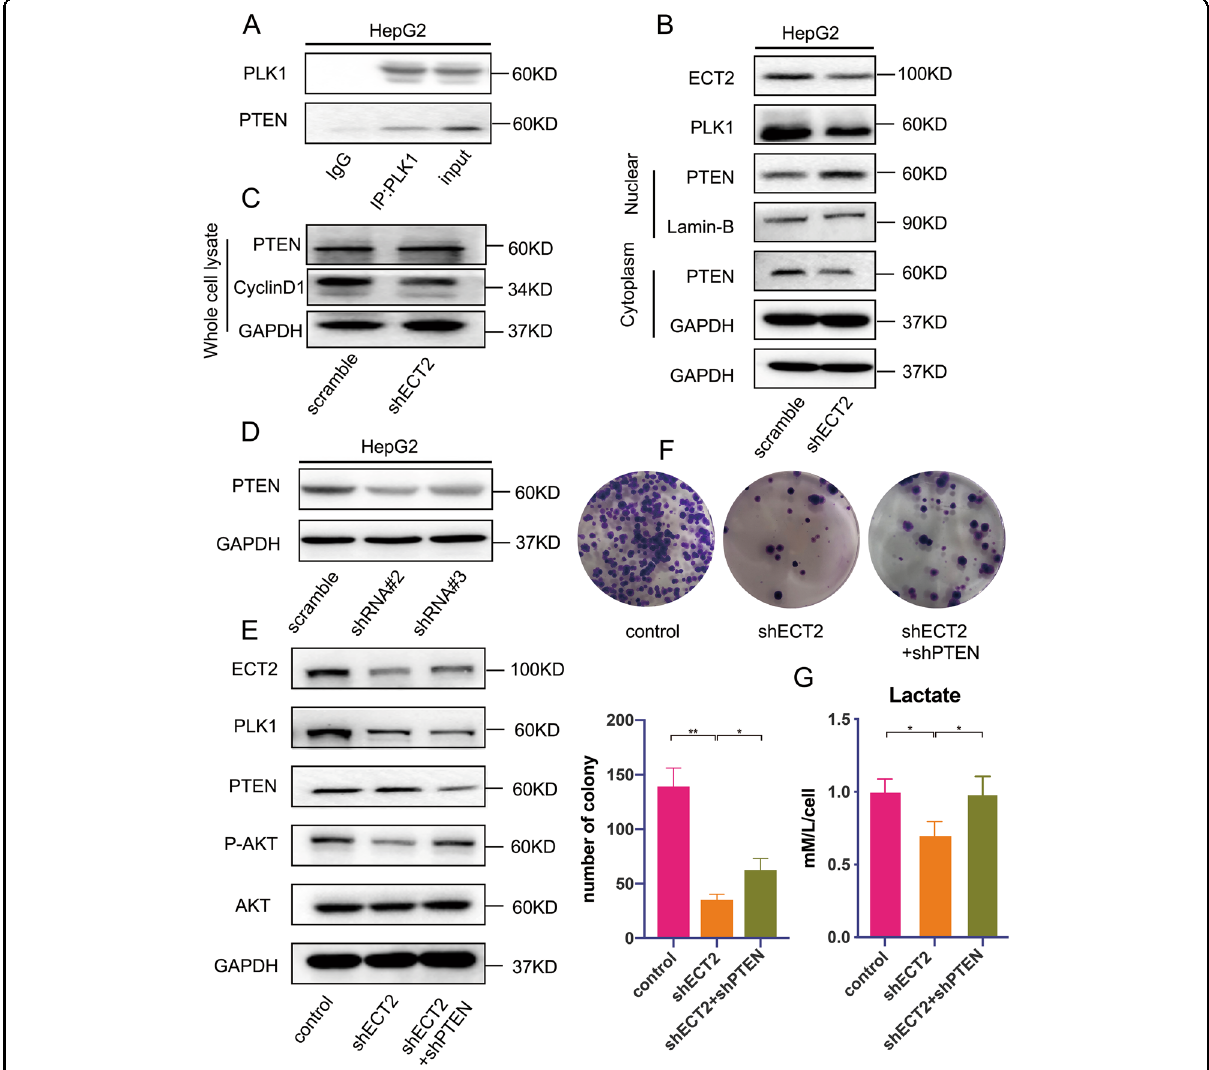
con fi rm cyclin D1 and PTEN expression levels in whole-cell lysate after ECT2 was downregulated. D Western blot analysis was used to evaluate the effect of PTEN knockdown. E Western blot analysis of p-AKT, PLK1, and AKT expression levels after ECT2 or PTEN knockdown in the HepG2 cell line. F Cancer cells transfected with ECT2- and PTEN-targeting shRNA were assayed for clonogenicity in adherent cultures. G Lactate acid production by cancer cells was evaluated after ECT2 knockdown. Error bars represent means ± SD. * p < 0.05, ** p < 0.01. NS means “ not signi fi cant ” by paired two- sided Student ’ s t